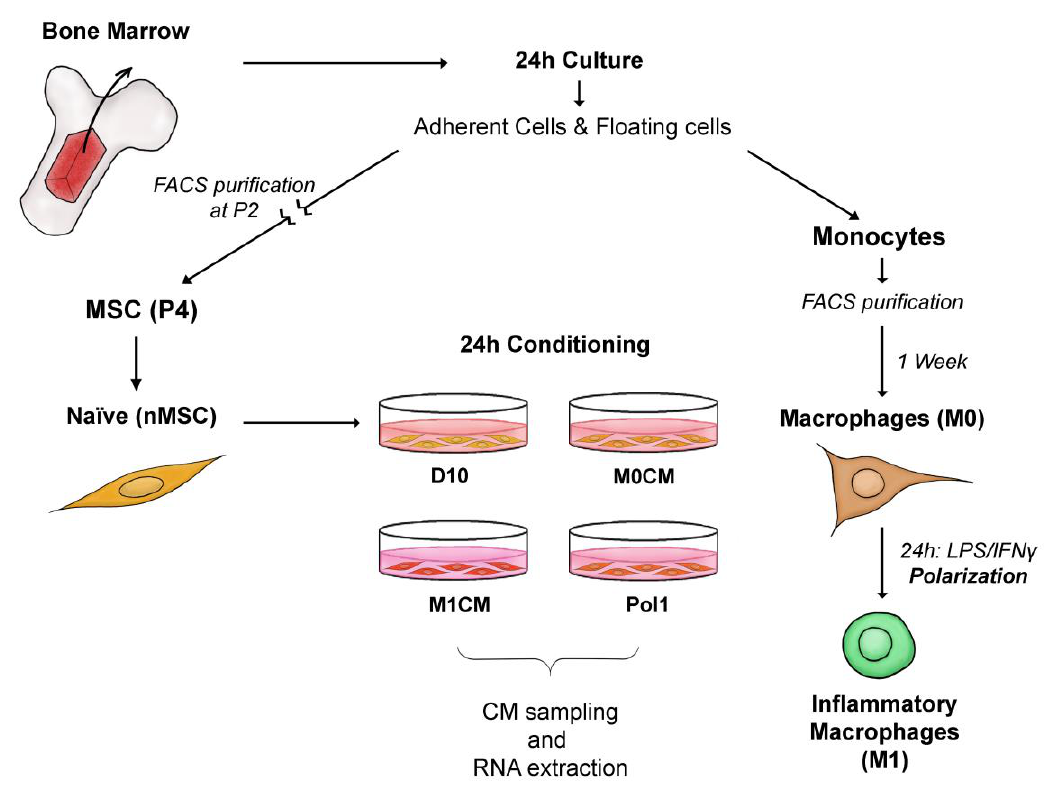
Figure 1. Experimental paradigm. The bone marrow was extracted from femurs and tibias of four rats and cultured on uncoated plastic dishes. After 24 h, mesenchymal stromal cells (MSCs) that adhered to the dish remained in culture and the supernatants were used to sort floating monocytes through FACS. Sorted monocytes were cultured for 1 week on uncoated plastic dishes with R10 medium supplemented with M-CSF to induce differentiation to macrophages. After 1 week, part of the macrophage culture received fresh R10 to remain unpolarized (M0), while the other part received a polarization cocktail with LPS and IFN γ to induce the pro-inflammatory phenotype (M1). In parallel, the MSC culture continued independently. MSCs were purified through FACS at passage 2 (P2) and cultured until P4 on poly(D)-lysine (PDL)-coated dishes. At P4, MSCs were conditioned for 24 h in separate batches with the CM collected from the two macrophage cultures, with the polarization medium used to induce the M1 phenotype and with fresh D10. M0CM, Pol1 and D10 served as controls for the experimental condition M1CM. The CM and RNA was collected from all conditioned MSCs to study the secretome and transcriptome. Abbreviations : FACS: fluorescence activated cell sorting; MSC: mesenchymal stromal cell; CM: conditioned medium; (D10, M0CM, M1CM, Pol1) represent the media in which naïve MSCs were cultured for conditioning: D10: DMEM medium with 10% fetal bovine serum and 1:1000 gentamycin; M0CM: M0 macrophage conditioned medium;